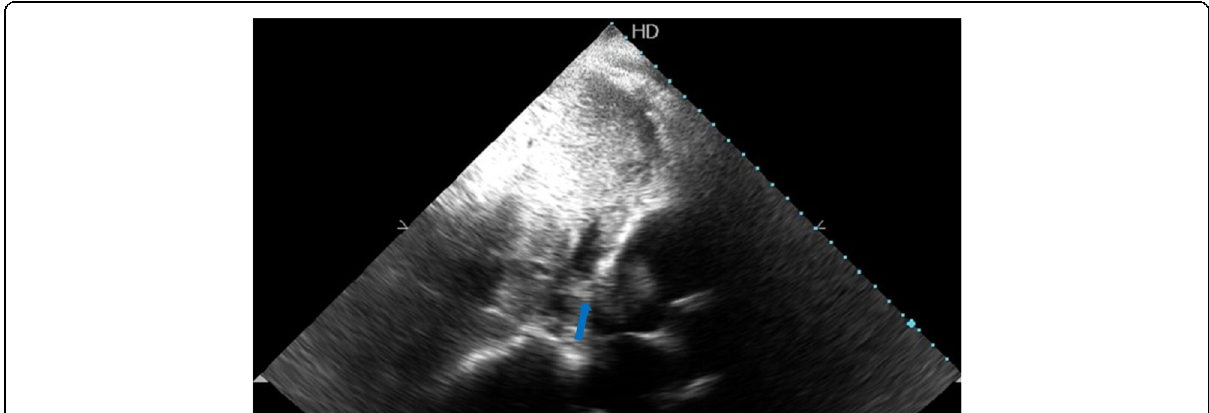
Fig. 4 TTE subcostal view showing tumor thrombus extending from the IVC towards the right atrium marked by a blue